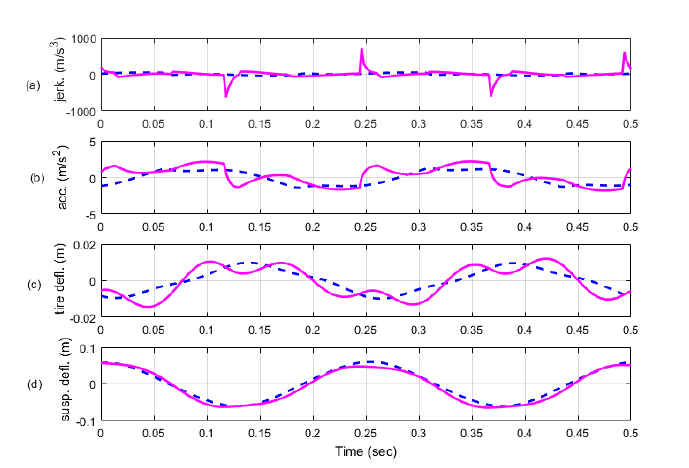
Figure 4. ( a – d ) Time responses of semi-active system with 0.1 s preview time to harmonic input of frequency 25 (rad/s) using (i) 1st weighting sets: – – – – ; (ii) 2nd weighting sets: ——– .